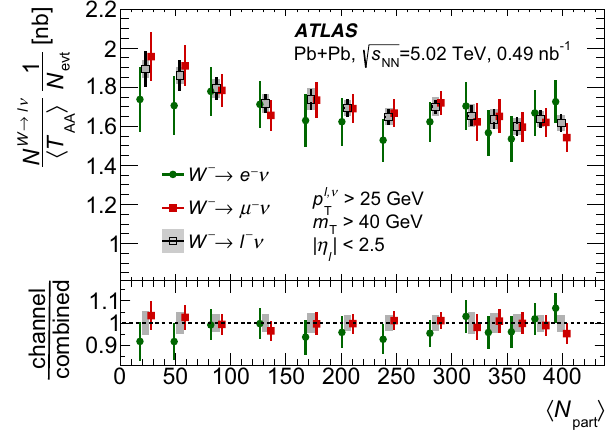
to (cid:4) T AA (cid:5) are not included. The lower panels show the ratios of channels to combined yields in each bin with error bars and shaded boxes rep- resenting the total uncertainties of the channels and combined yields, respectively. The points for individual channels are shifted horizontally for better visibility